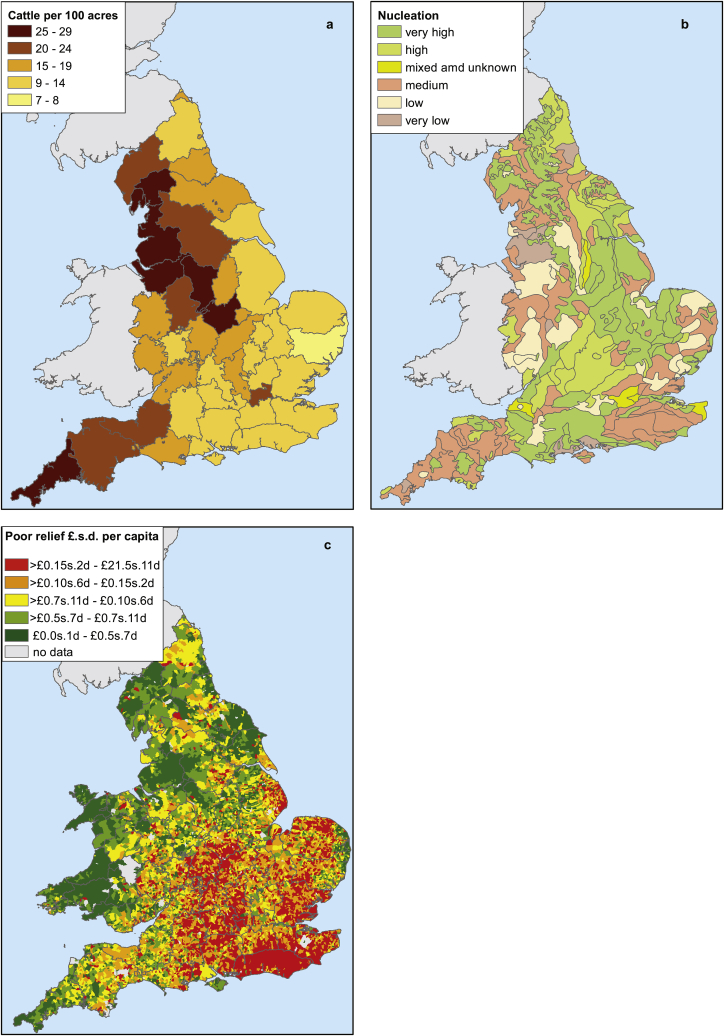
Cattle densities per 100 acres in 1870 (a), settlement nucleation patterns (b), and per capita poor law expenditure by parish in 1803 (c). Source: Parliamentary Papers, 1803-04, Parliamentary Papers, 1870; Lowerre et al. (2011).